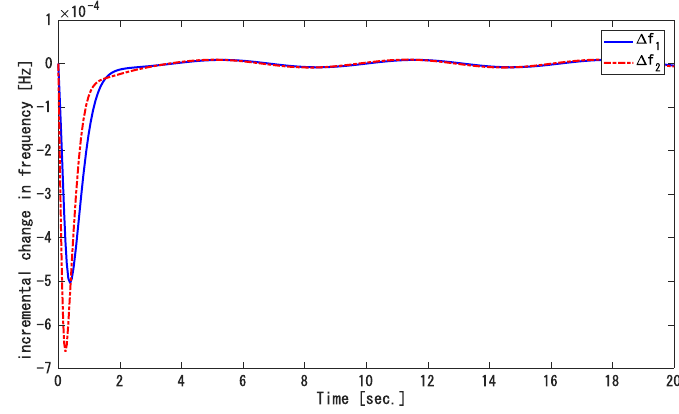
Figure 5. The frequency deviations.